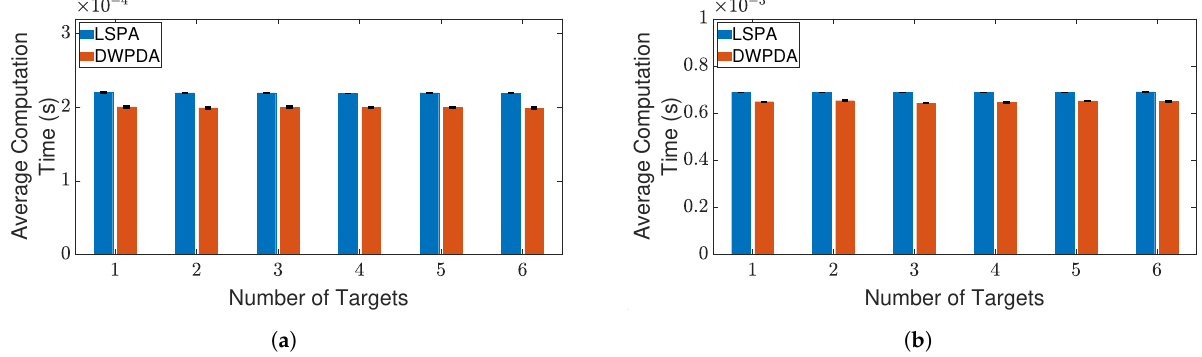
Figure 6. Average computation time for obtaining association probabilities using DWPDA and LSPA for tracking mul- tiple crossing targets with different clutter densities. ( a ) Clutter density λ = 1 × 10 − 4 /m 2 ; and ( b ) clutter density λ = 5 × 10 − 4 /m 2 . Error bars indicate 95% confidence